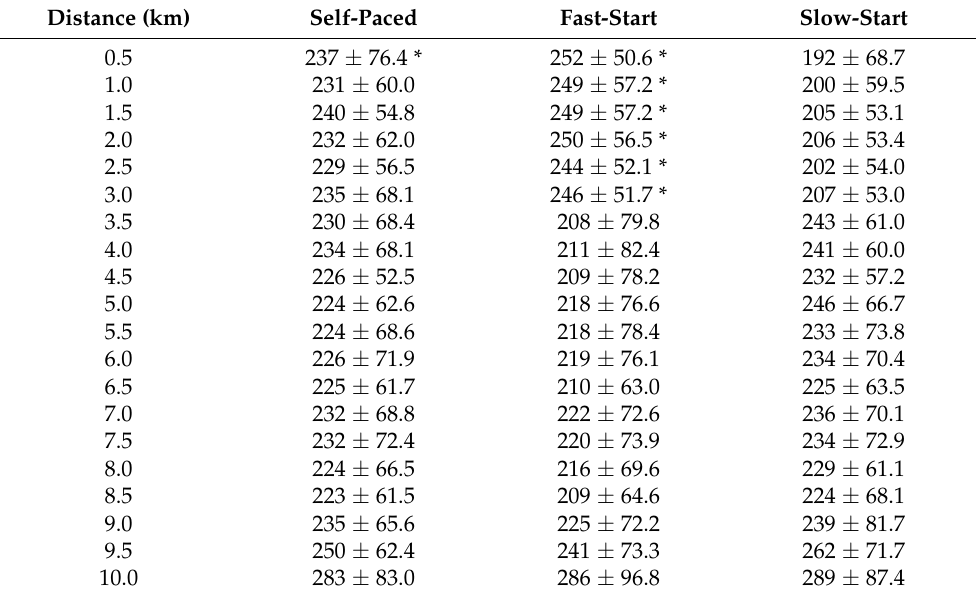
Table 3. Means ± standard deviations of power output (W) during self-paced, fast-start, and slow- start time trials.